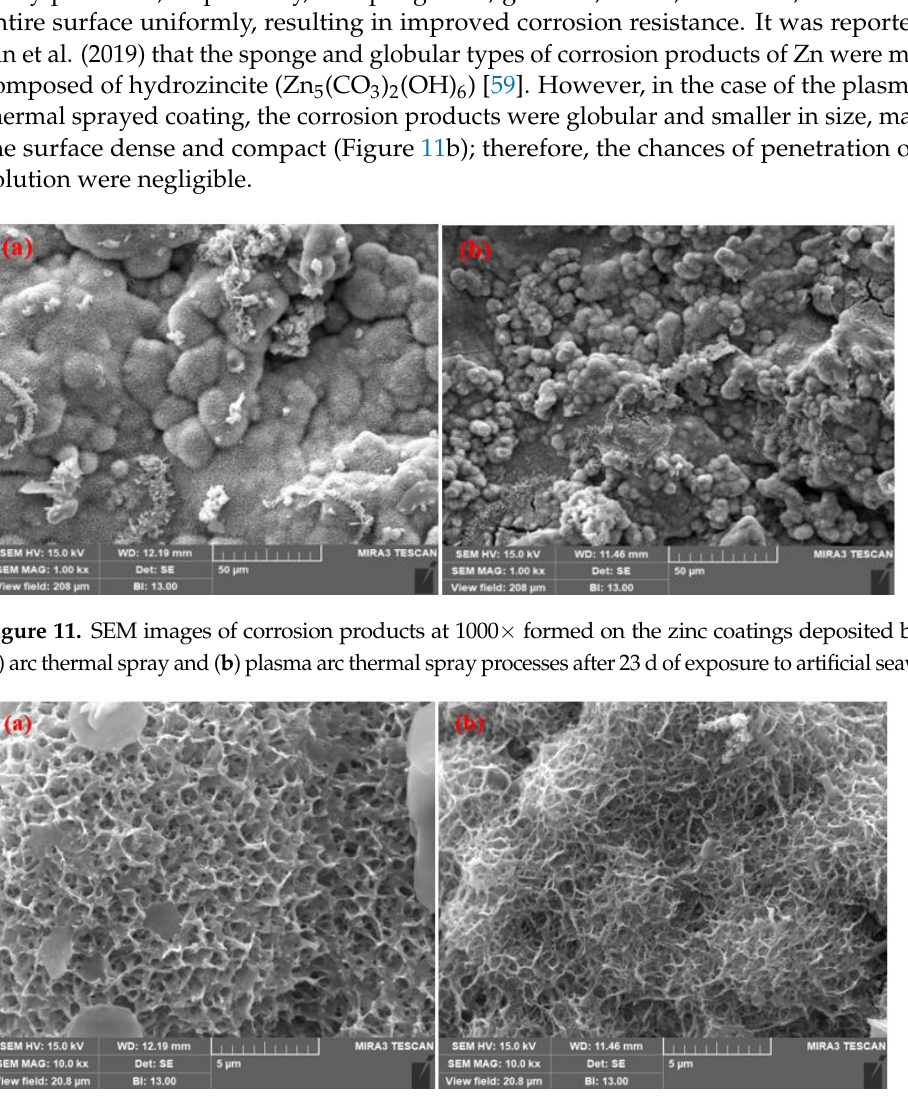
Figure 13. SEM images of cross-sectional views of corrosion products formed on the zinc coatings deposited by the ( a ) arc thermal spray and ( b ) plasma arc thermal spray processes at 500× after 23 d of exposure to artificial seawater. Table 6. EDS analysis of corrosion products. Coating Process